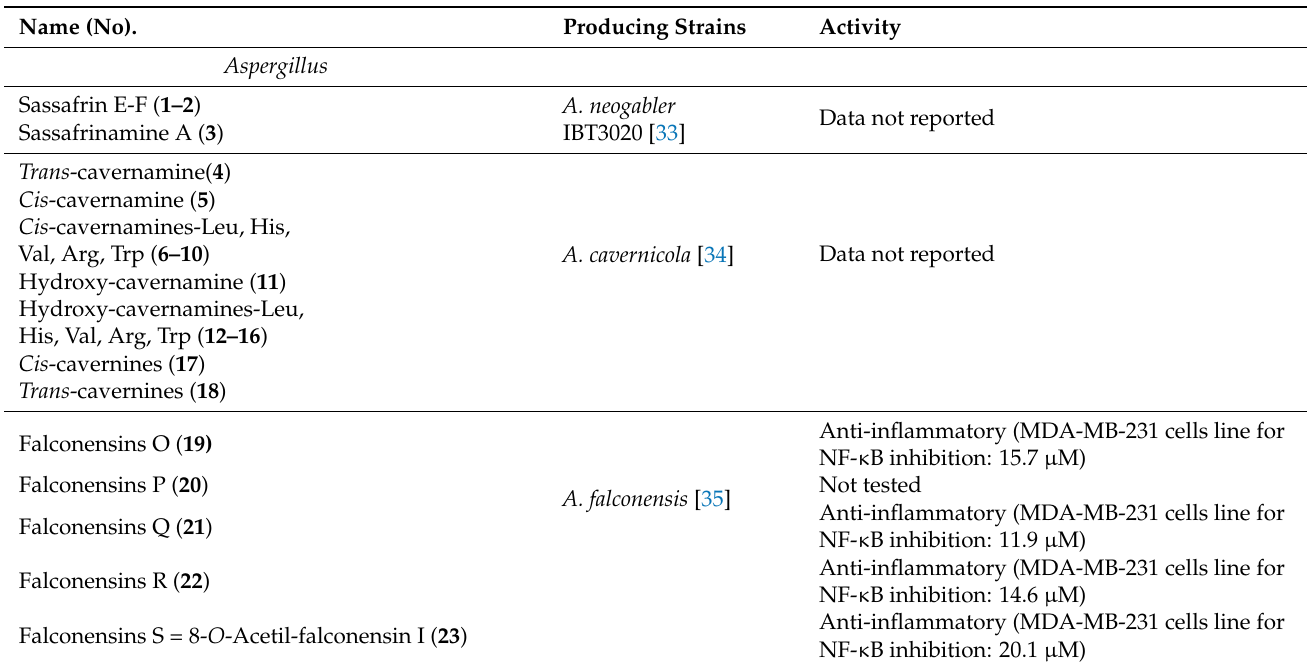
Table 1. Azaphilones fungal sources and reported biological